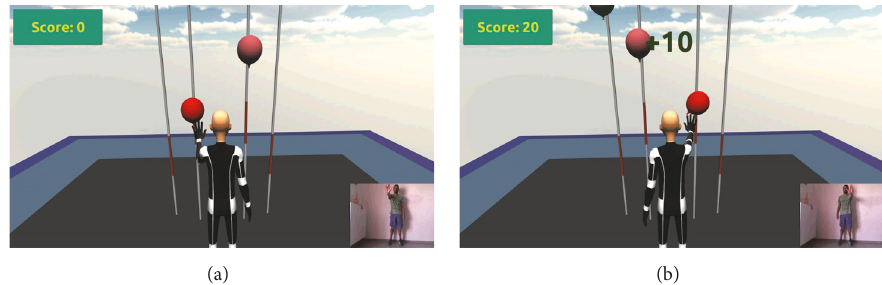
Figure 4: Balloon Goon Game. Sample screenshots of a left (a) and a right (b) “punch” animation performed by the avatar shown in the main screen. Each of these animations is triggered by successfully detecting a left/right “Arm Extension” gesture executed by the human actor, as shown in the corresponding bottom right corner insert for each screenshot.